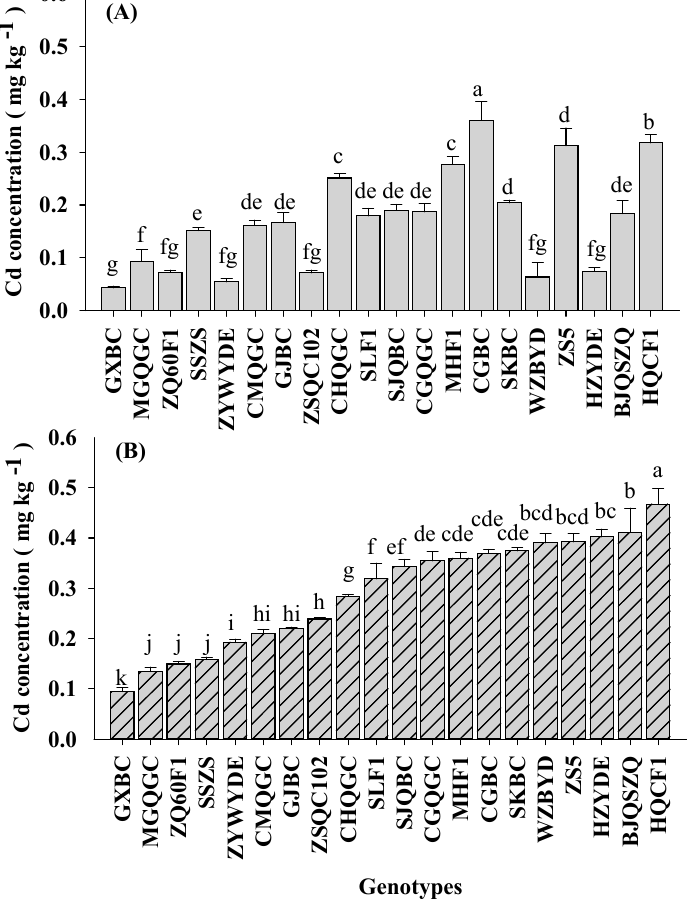
Figure 2. Shoot Cd concentrations in pakchoi among 20 genotypes grown in low-level co-contaminated soil ( A ), and high ‐ level co ‐ contaminated soil ( B ). Error bars depict standard errors of the means ( n = 3). Different letters depict significant difference among genotypes according to LSD test ( p < 0.05).